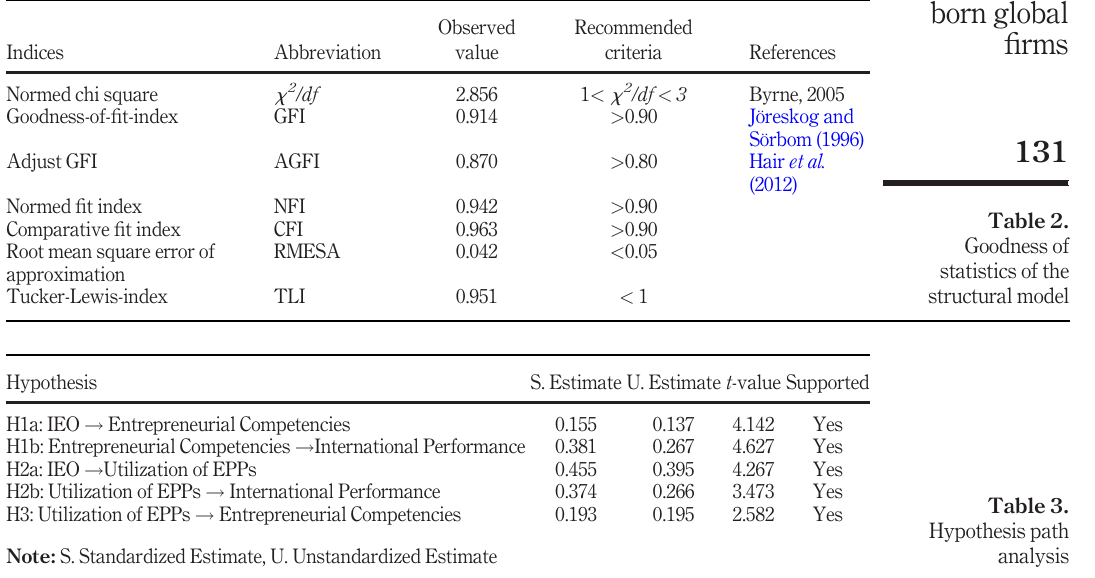
Table 3. Hypothesis path